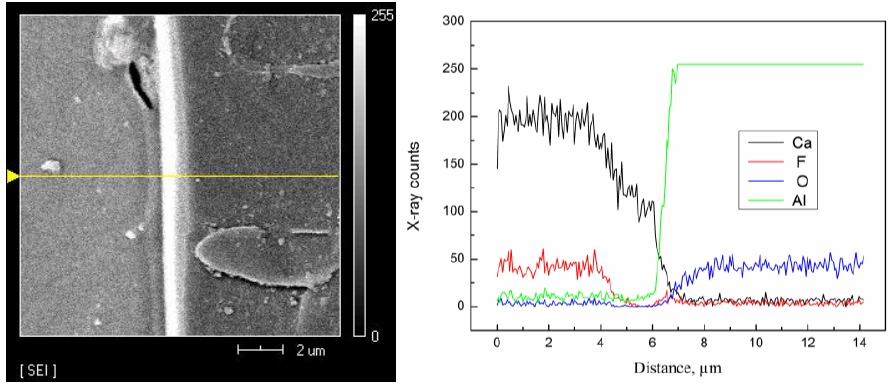
Figure 8. SEM-SE image of the dissolution boundary between the inclusion and slag S2 as well as line-scanning results of the boundary layer by SEM-SBSE.